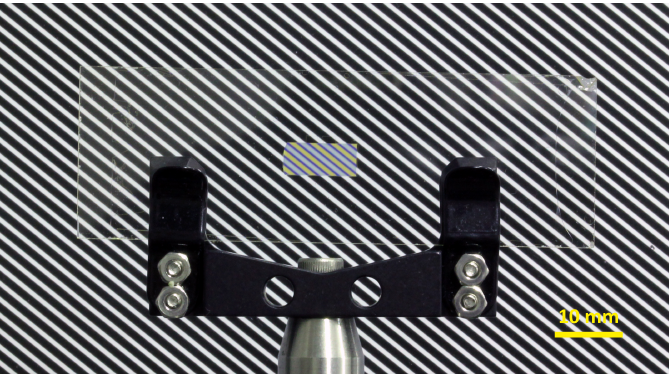
Figure 7. Close-up photography of one of the fabricated gratings (in the middle of the picture). Behind, you can see a periodic object to better observe the dimensions of the grating with respect to the glass substrate. The grating grooves are arranged